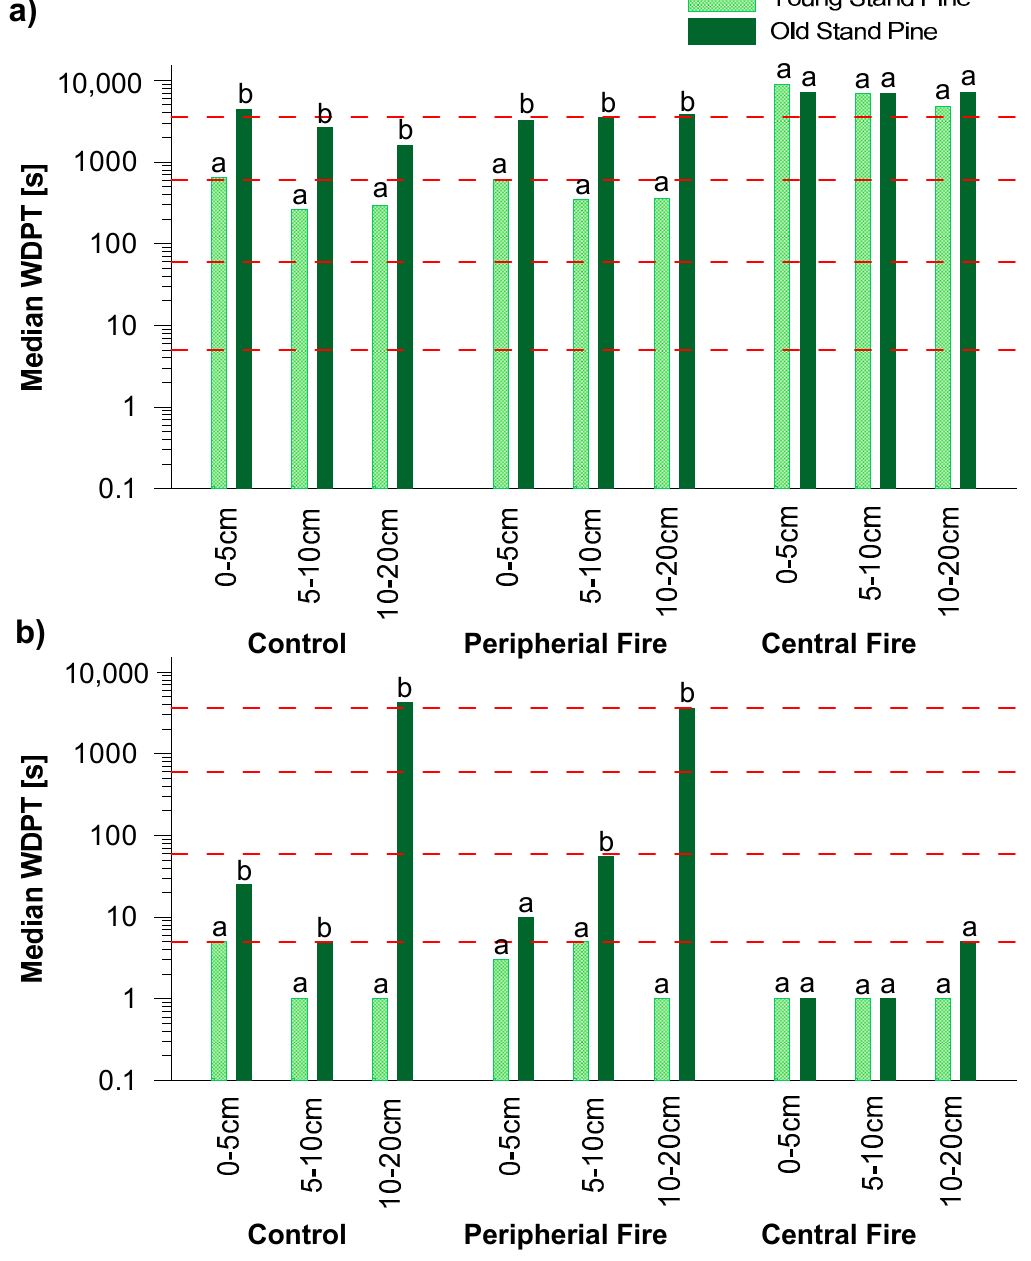
Figure 4. Median WDPT values for soil under a young and old pine stand for 0–5 cm, 5–10 cm, and 10–20 cm soil samples taken from the control site, peripheral fire site, and central fire site, ( a ) 1 month after the fire and ( b ) 13 months after the fire. The different letters denote significant differences in pine stand samples, determined by the Mann–Whitney test ( α < 0.05). The dashed lines denote SWR classes.